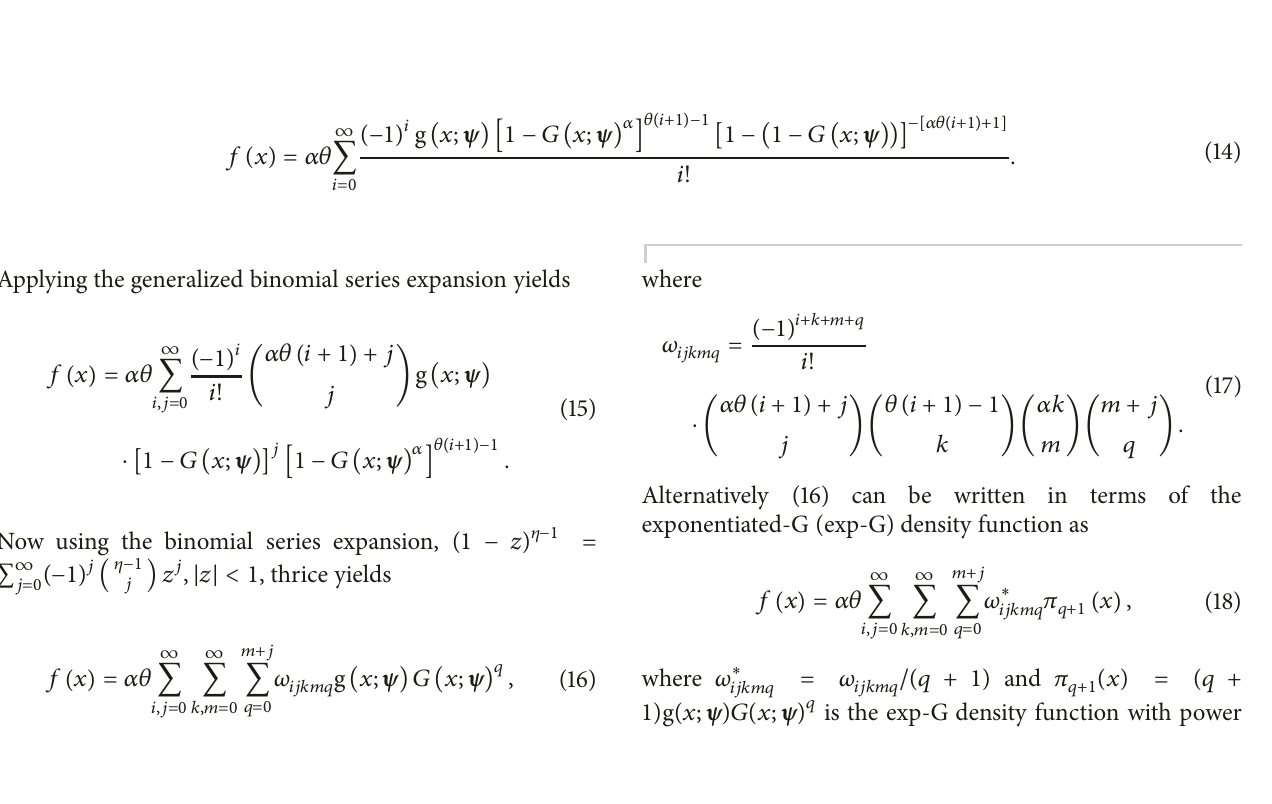
Figure 2: Plots of the EOFNH distribution hazard rate